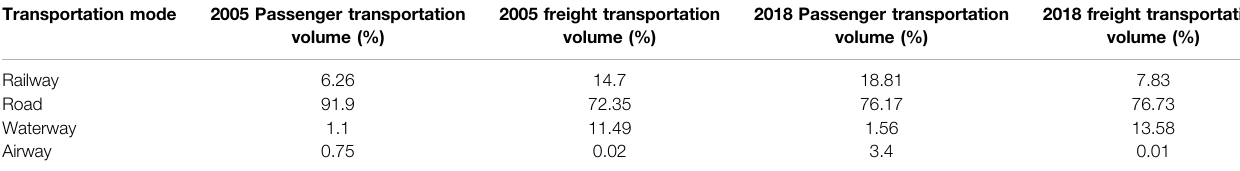
TABLE 1 | The proportion of annual passengers and freight transportation volume for various transportation modes in China.